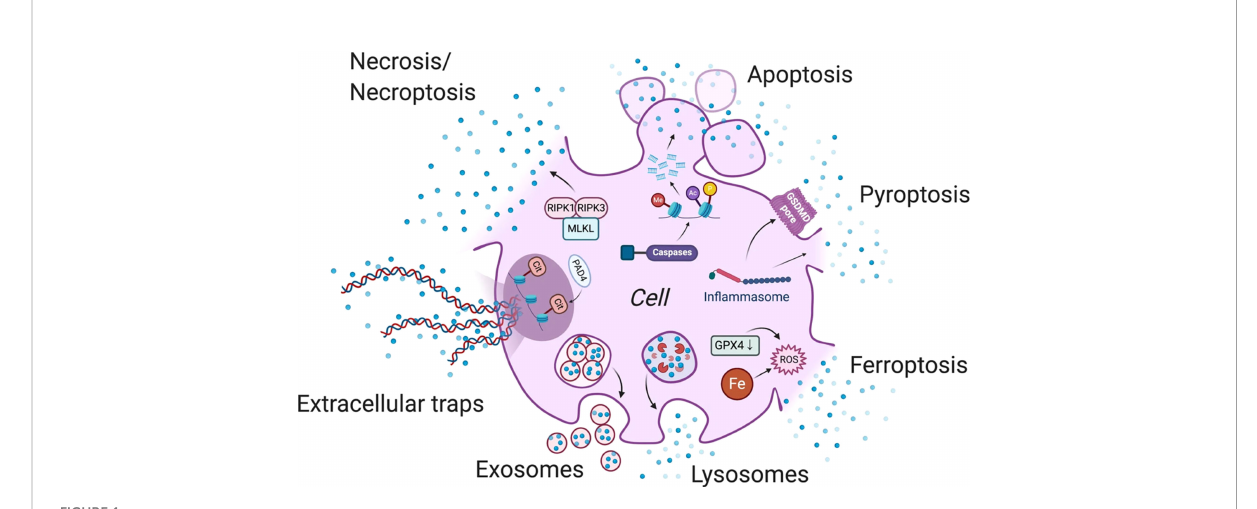
FIGURE 1 Universal mechanisms of DAMP